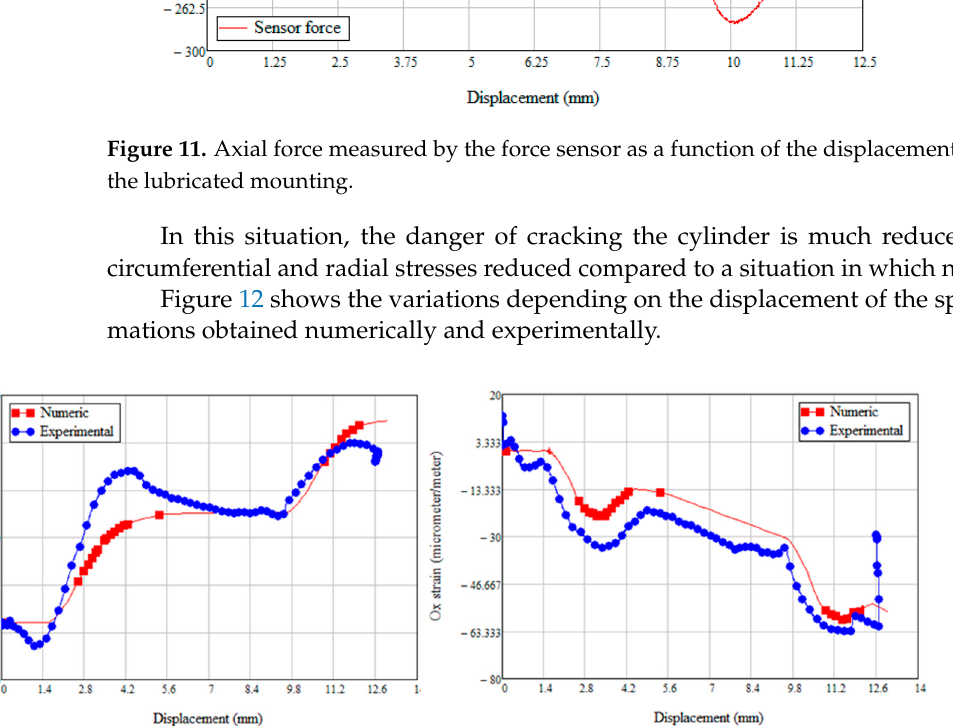
Figure 11. Axial force measured by the force sensor as a function of the displacement of the lid for the lubricated mounting.